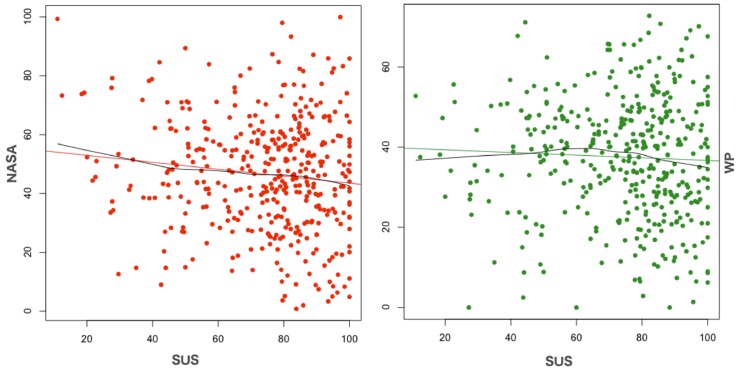
Scatterplots of NASATLX, WP vs SUS.